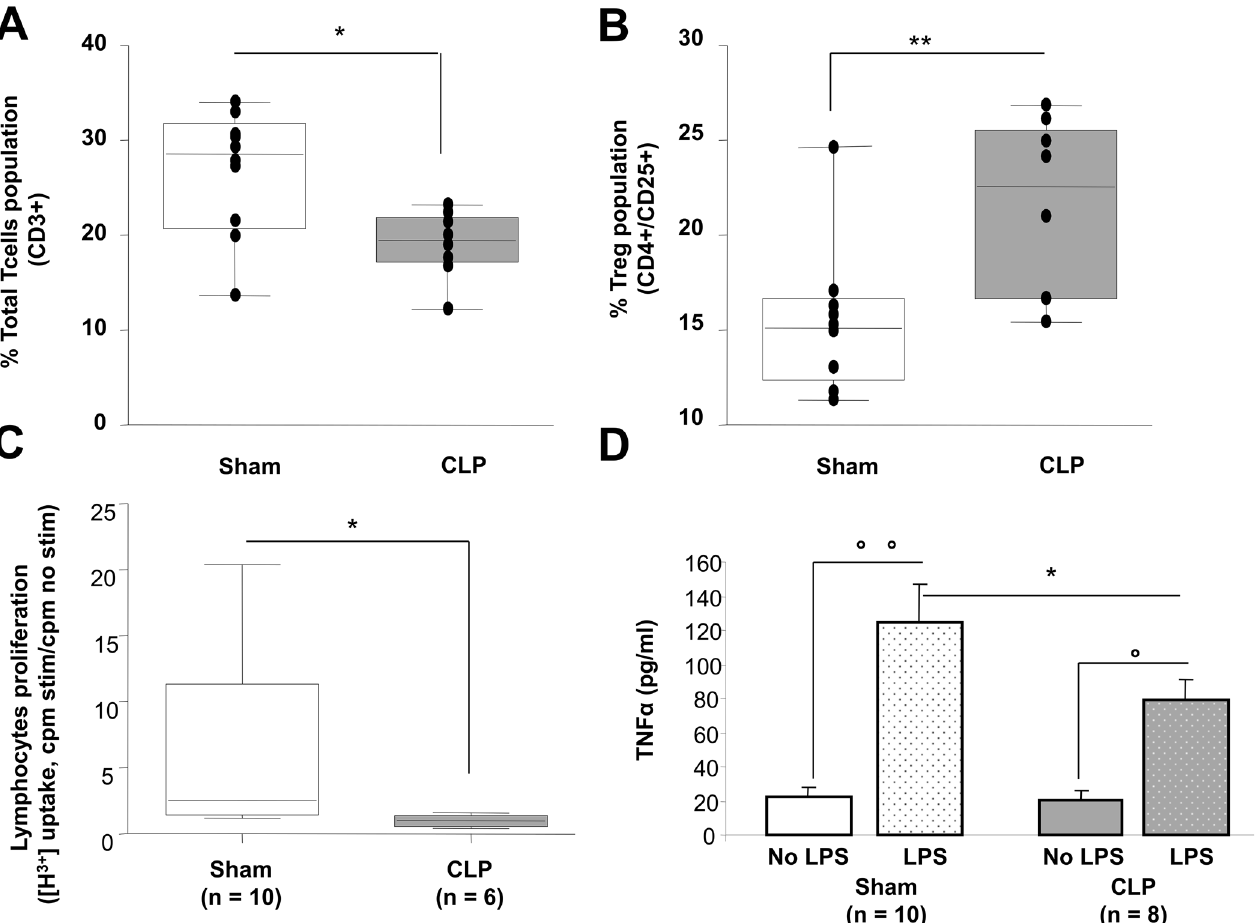
Fig 4. Immunological assay. Spleens were harvested at D5 and splenocytes were rapidly isolated in order to determine T cells characteristics (population, proliferation, and TNF α secretion). As compared to Sham-operated animals (n = 10), total T cells population (CD3+) in CLP mice (n = 8) decreased (A) among which Treg fraction (CD4 + /CD25 + ) increased (B). In parallel, T cells proliferation, assessed by a stimulation with an anti-CD3 + antibody (200 000 splenocytes / anti CD3 coated wells (1 μ g/ml)) and incorporation of [ 3 H]-thymidine was diminished (C). Radioactivity counts reflect the lymphocytes proliferation. Results are expressed as proliferation ratios between counts per minute measured in stimulated (cpm stim) versus non-stimulated (cpm no stim) wells for the same experiment. Splenocytes ability to produce TNF α when stimulated for 24 hours with LPS (200 000 cells/well, LPS 1 μ g/ml) was also decreased (D). * p < 0.05 Mann Whitney U test, ** p < 0.01 Mann Whitney U test, °p < 0.05 Wilcoxon paired test °°p < 0.01, Wilcoxon paired